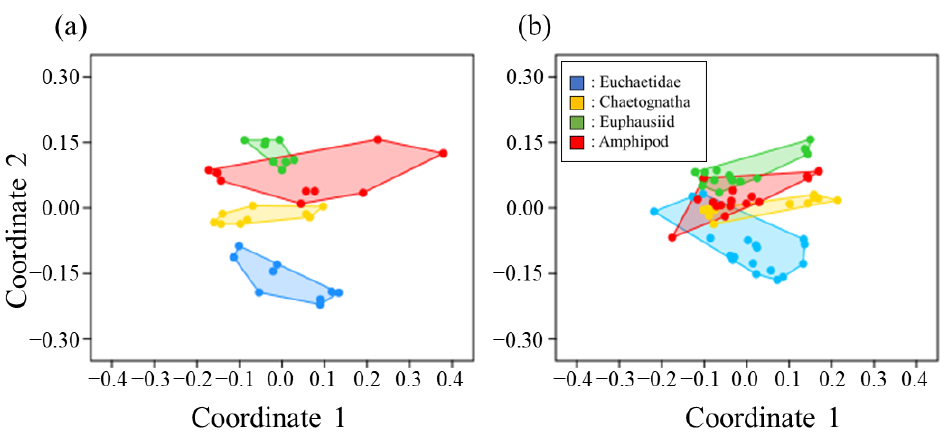
Figure 7. NMDS ordination of fatty acids and stable isotopes from four zooplankton taxa (Euchaetidae, Chaetognatha, Euphausiid, and Amphipod) during high productivity period ( a ) and low productivity period ( b ). Each color represents the different zooplankton taxa (Blue: Euchaetidae, Yellow: Chaetognatha, Green: Euphausiid, Red: Amphipod). The stress values of each graph were 0.15 and 0.14. Both values are less than 0.2, which indicates that the given data set is suitable for visualization within an acceptable level of distortion.